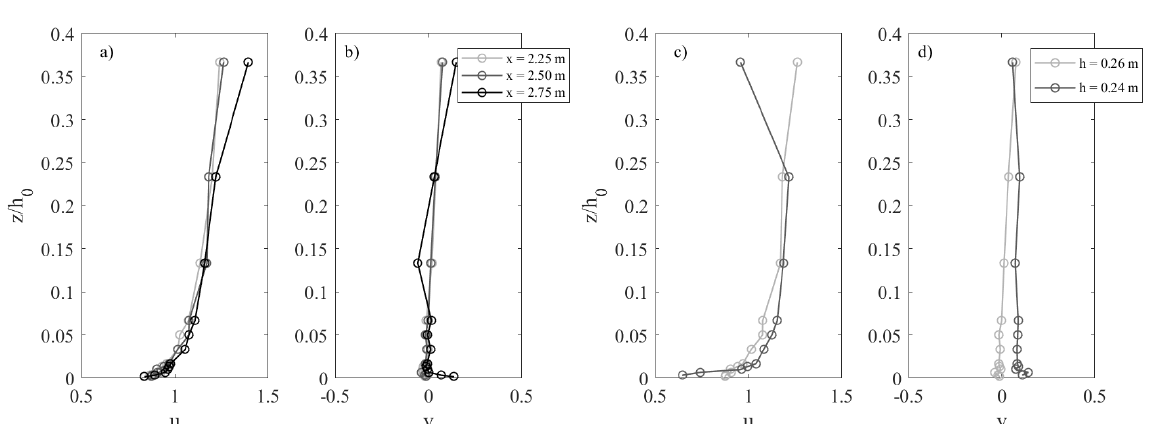
Figure 5. Dimensionless time-averaged u and v velocity profiles in the streamwise and crosswise directions: velocity profiles of u ( a ) and v ( b ) for the CO tests 2, 4 and 5, (CC, US and DS respectively) thus all aligned in the x direction ( y = 1.00 m) having the same local water depth h = 0.26 m; velocity profiles of u ( c ) and v ( d ) for tests 2 and 6, (CC and SH respectively) thus both aligned in the y direction ( x = 2.50 m) with local water depth of h = 0.26 m and 0.24 m